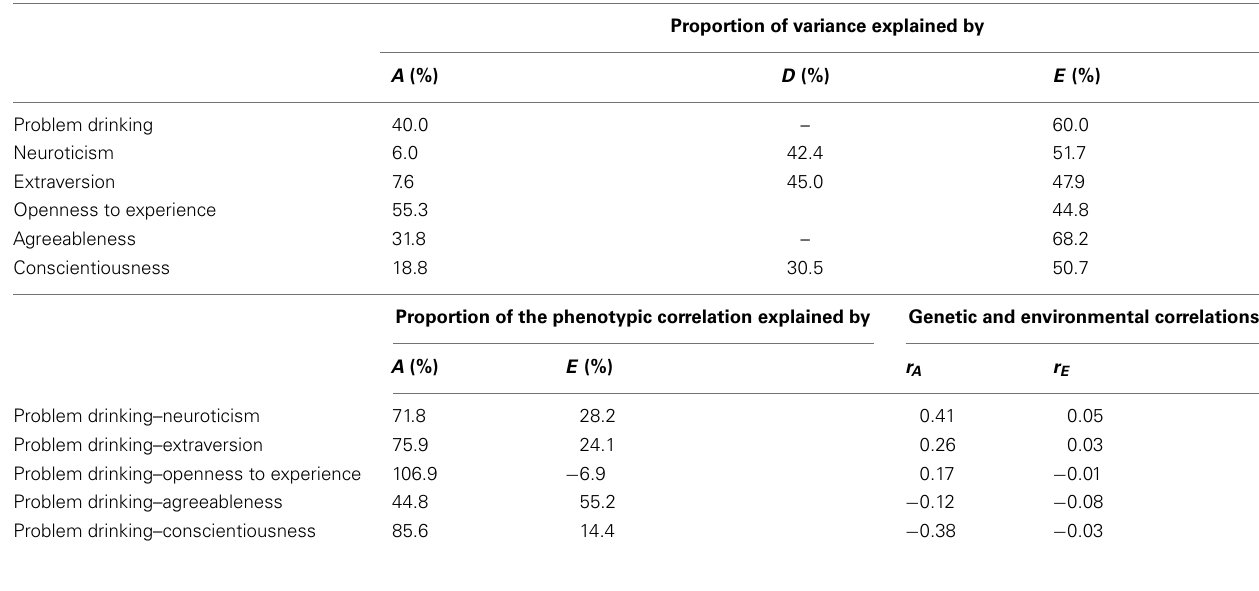
Table 4 | Proportions of variance and the phenotypic correlations explained by genetic and environmental factors and genetic and environmental correlations as obtained from the genetic models for problem drinking and